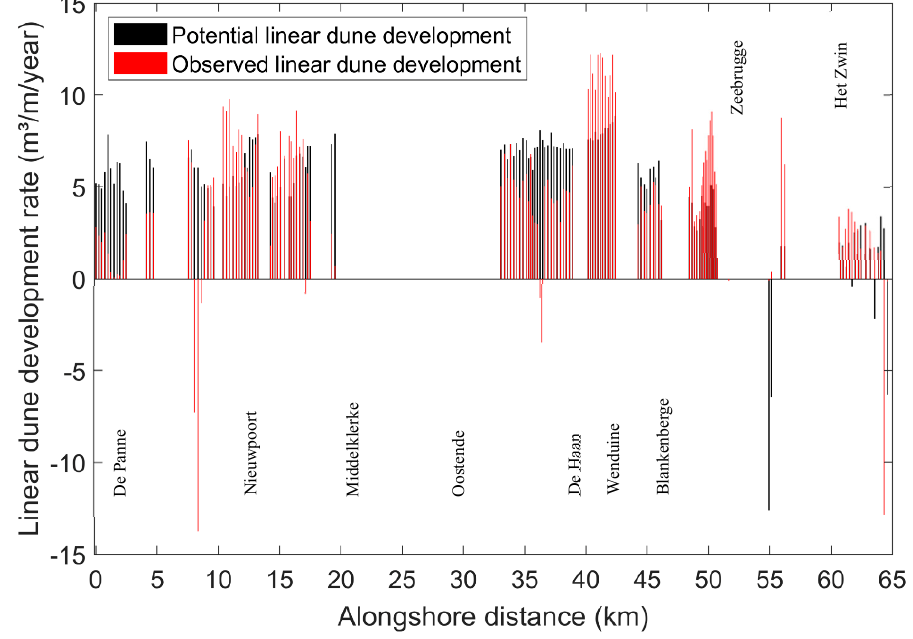
Figure 27. Annual predicted and observed dune volume change along the Belgian coast on a decadal timescale. Red and black bars indicate the observed and predicted values of dune development, respectively.